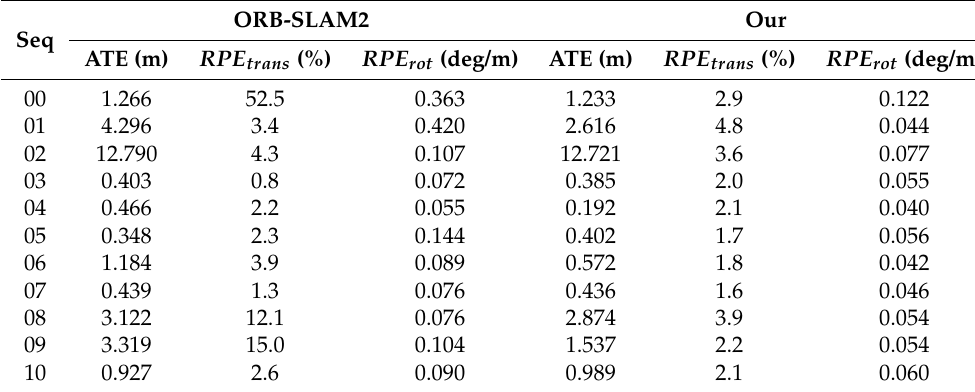
Table 1. Comparison between ATE and RPE on different SLAM